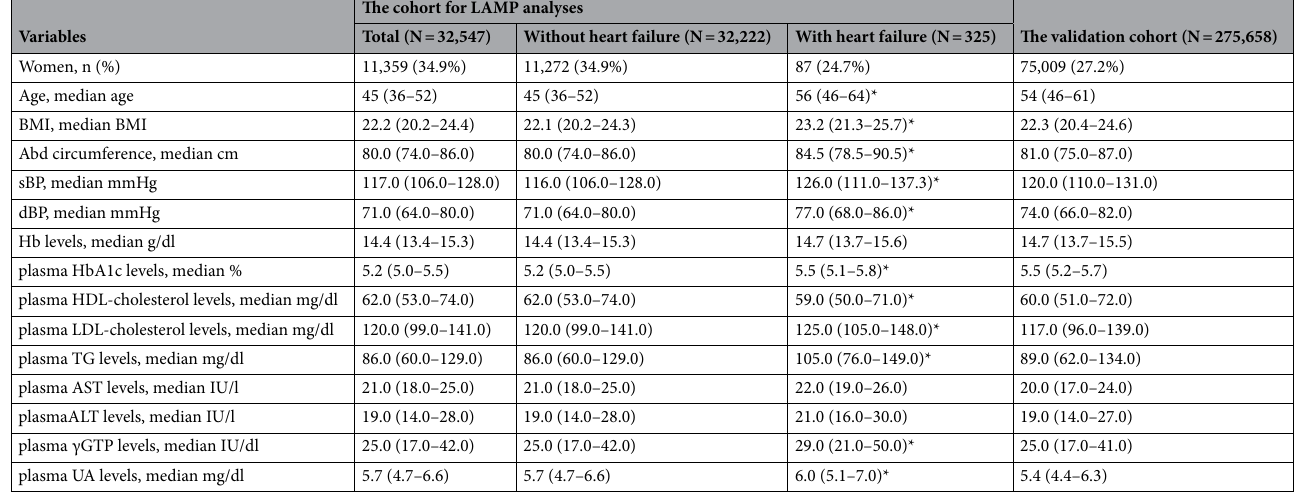
Table 1. Clinical characteristics of test and validation cohorts at baseline with or without the occurrence of heart failure in 4 years. BMI: body mass index, Abd circum: abdominal circumference, sBP: systolic blood pressure, dBP: diastolic blood pressure, Hb: hemoglobin, HbA1c: hemoglobin A1c, HDL: high density lipoprotein, LDL: low density lipoprotein, TG: triglyceride, AST: aspartate aminotransferase, ALT: alanine aminotransferase, γGTP: γ-glutamyl transpeptidase, UA: Uric Acid. Values are median (interquartile range), only values of "women" are number (percent). * P < 0.05 compared with the group without heart